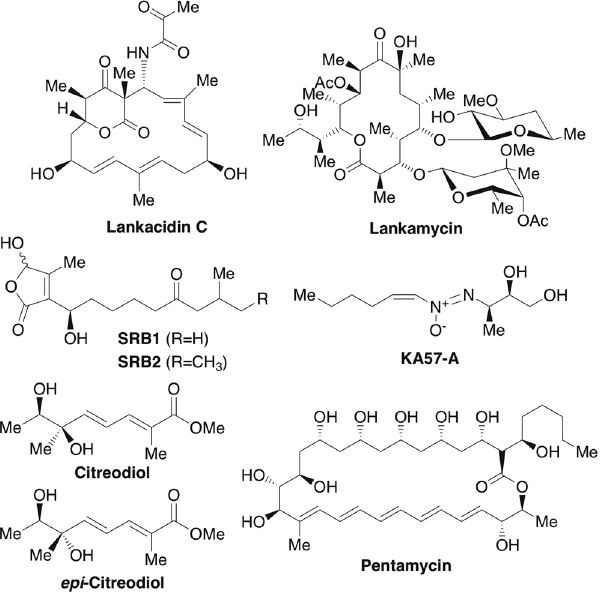
Figure 1. Secondary metabolites produced by Streptomyce rochei 7434AN4 and its mutants. Polyketide antibiotics; lankacidin C and lankamycin. Signaling molecules; SRB1 and SRB2. Azoxyalkene; KA57-A. Polyketides; citreodiol, epi -citreodiol, and